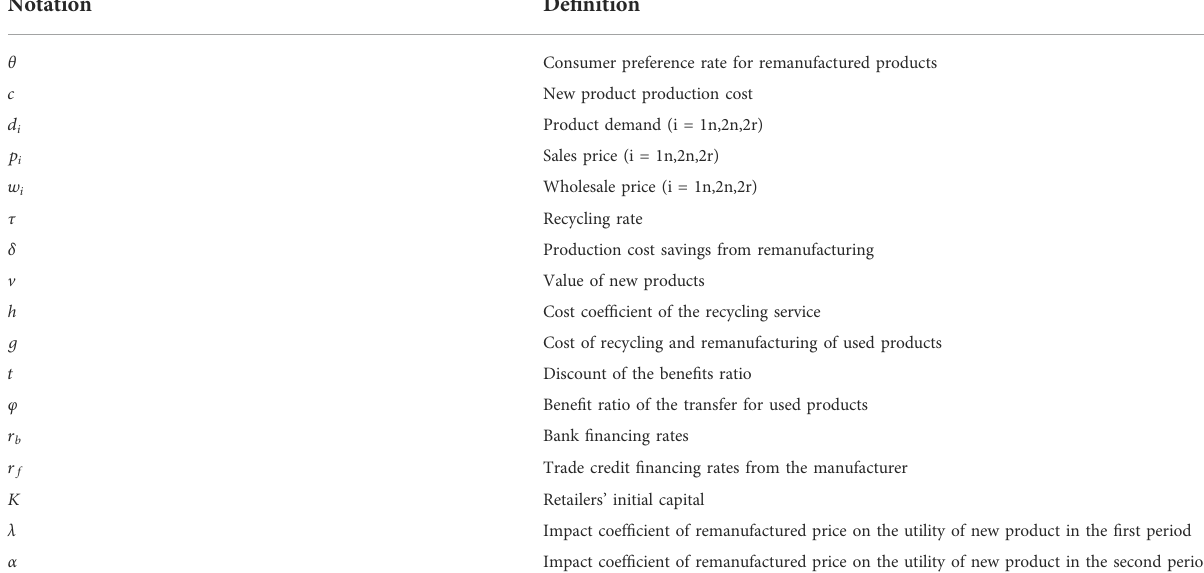
TABLE 2 Summary of